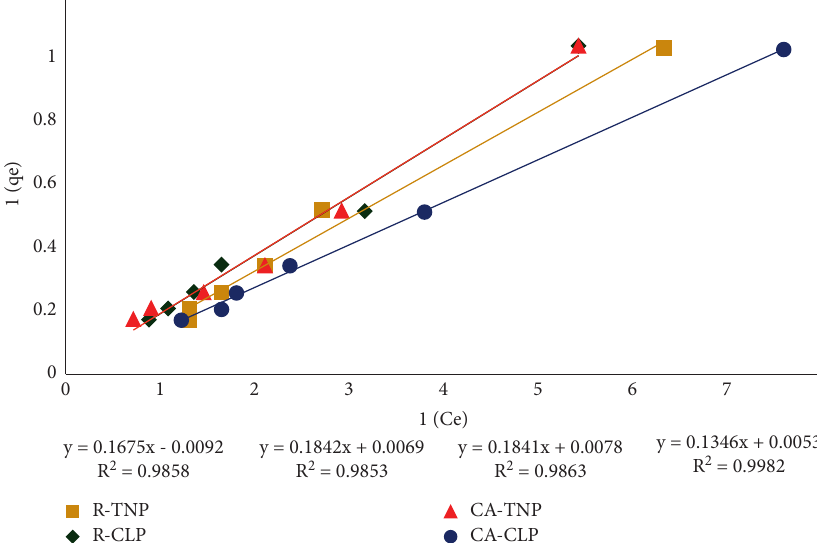
Figure 12: Comparison of the Langmuir isothermal effective parameter for the adsorption of BGD. Adsorbent dose � 0.5 g, contact time � 25min, temperature � 30 ° C, agitation speed � 100rpm, initial pH � 5, final pH: R-TNP � 5, R-CLP � 4.5, CA-TNP � 4.0, and CA- CLP � 4.0, and dye solution volume V � 100